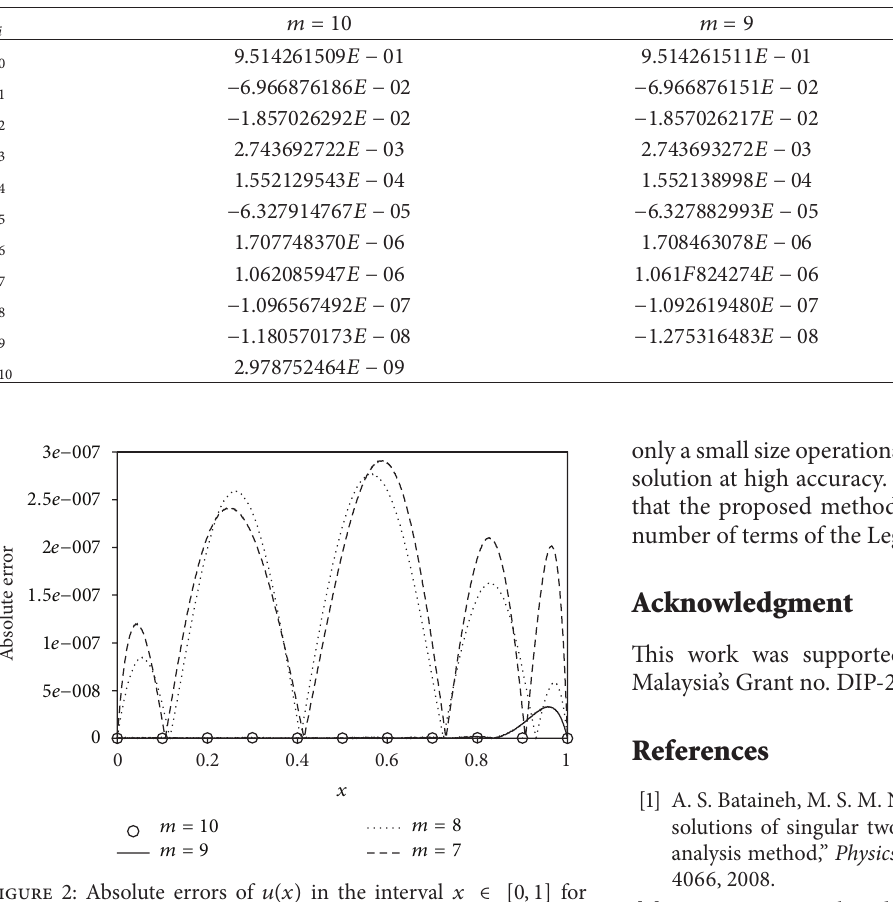
Table 2: The values of the unknown matrix 𝐶 𝑇 for 𝑚 = 8 , 𝑚 = 9, and 𝑚 = 10 of Example 4.